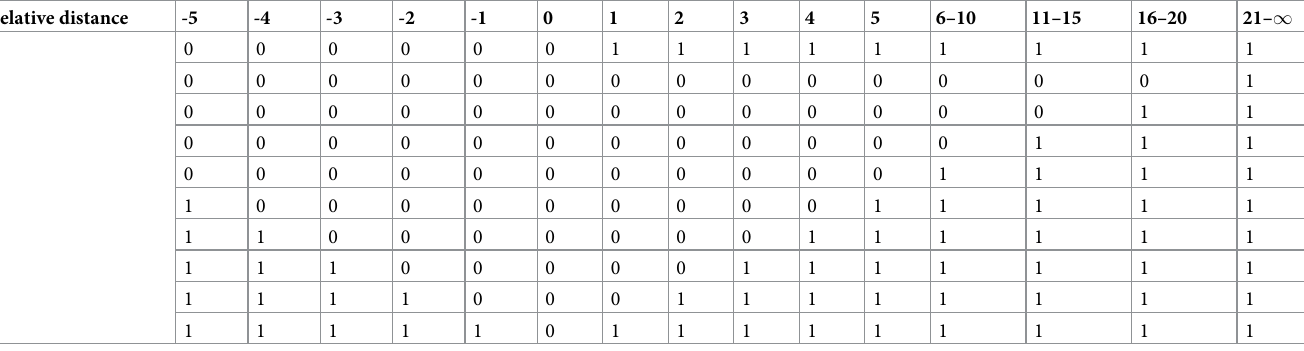
Table 2. Vector representation according to the distance between one of the target drugs and a current word. relative distance